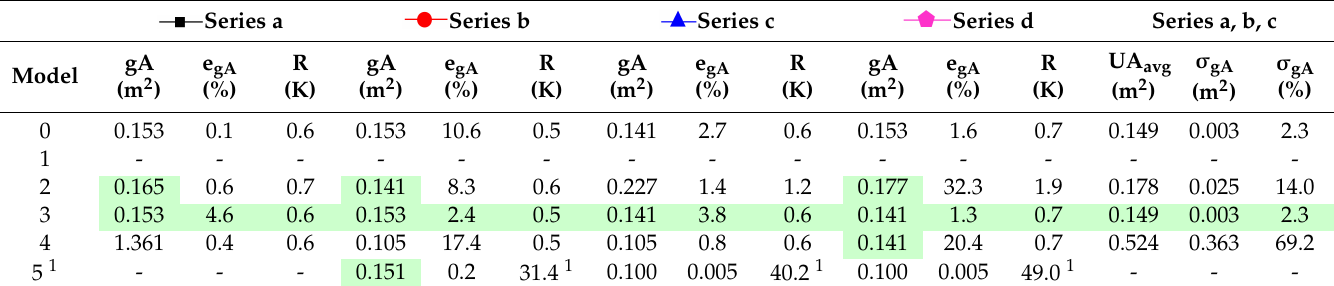
Table 15. Whole building. Models including non-measured variables. Output: T i . Summary of the results. gA values, and average of the